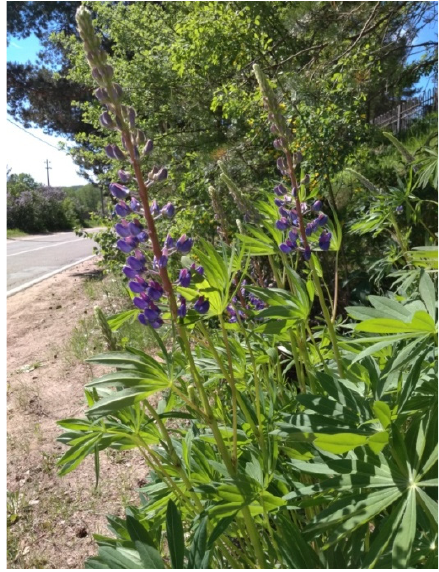
Figure 2. Lupinus polyphyllus on the side of the road in the village of Vinnitsy. Table 2. Geobotanical descriptions of plant communities with L. polyphyllus.